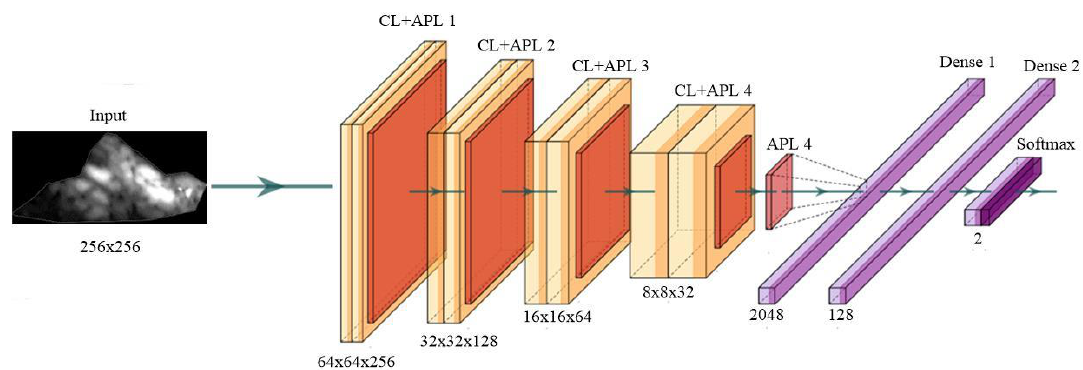
Figure A1. DCNN11 architecture (CL: convolution layer, APL: average pooling layer).